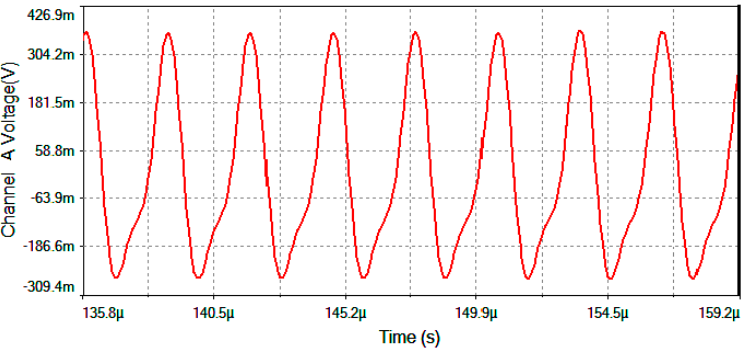
Figure 16. V filter output voltage after the BP Filter for Ω = +30 °/s.